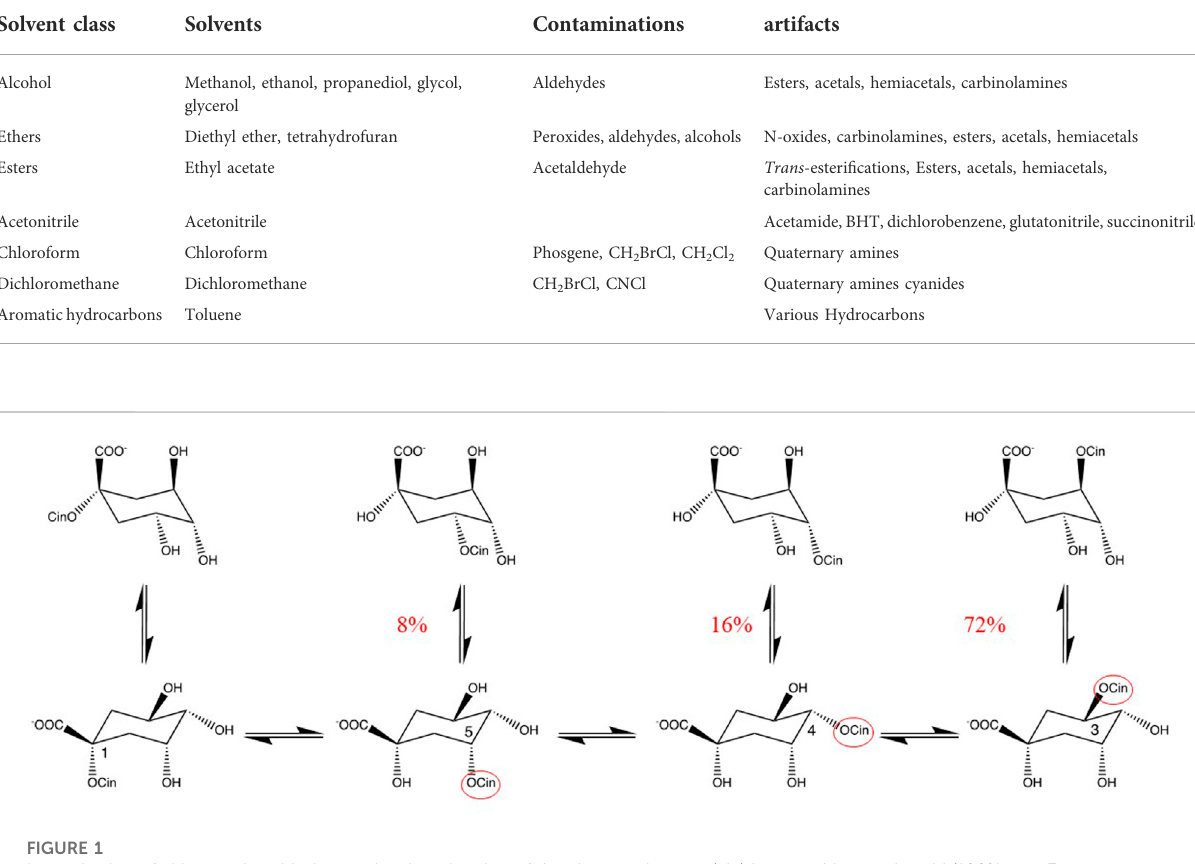
Isomerization of chlorogenic acids. Intramolecular migration of the cinnamoyl-group (cin) in pure chlorogenic acid (100% pure 3- cinnamoylquinic acid) when 3 min in phosphate buffer pH 7, at 90 ° C (Hanson, 1965). Percentages given are quantities relative the pure chlorogenic acid. cin =